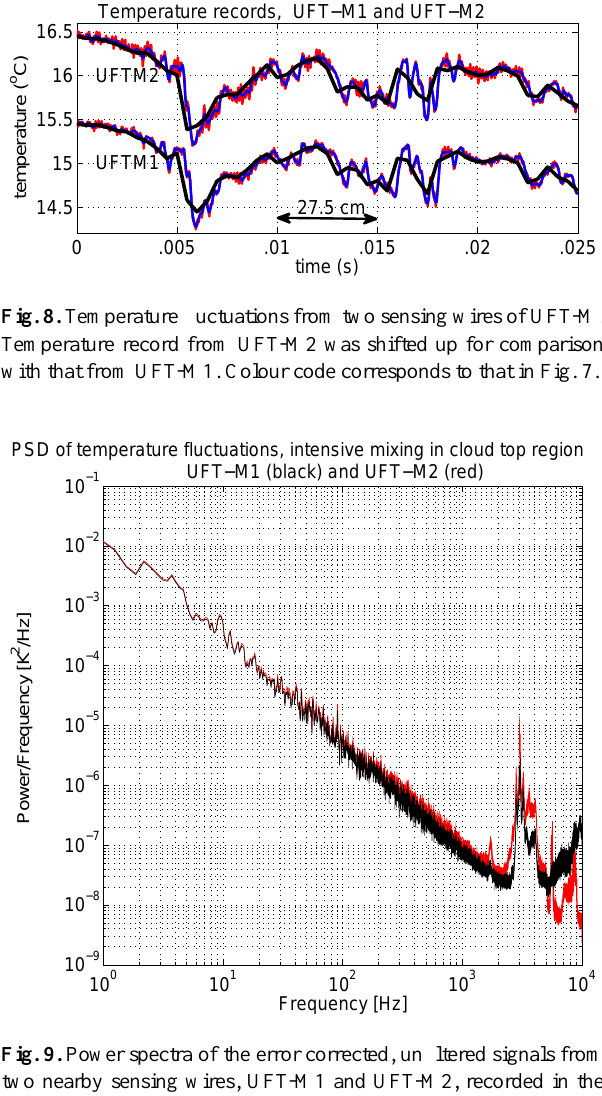
Fig. 9. Power spectra of the error corrected, unfiltered signals from two nearby sensing wires, UFT-M1 and UFT-M2, recorded in the region of intensive turbulent